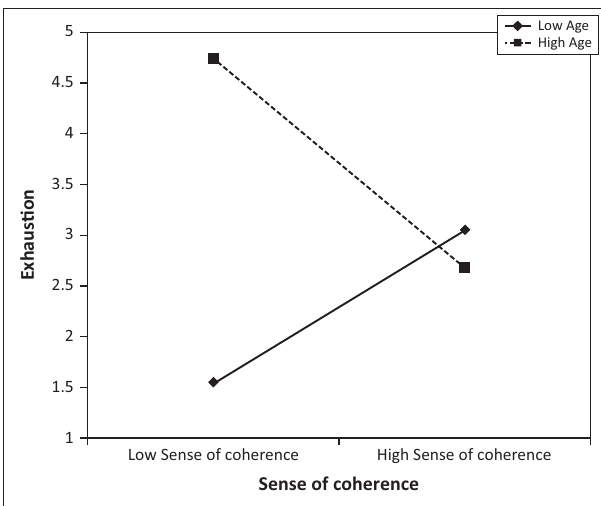
FIGURE 1: Interaction between sense of coherence and age with exhaustion as dependent variable.